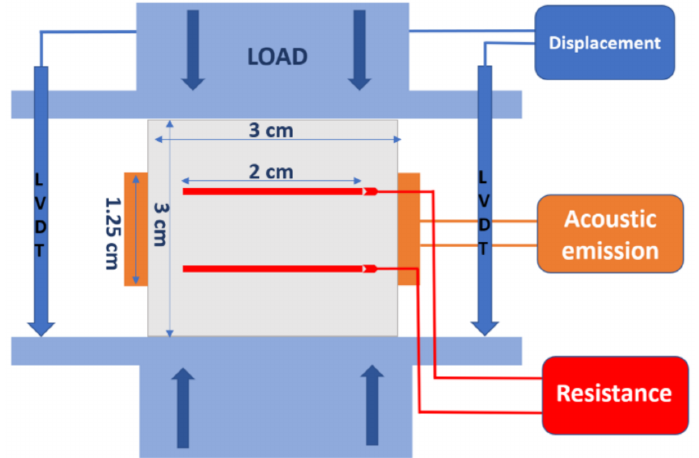
Figure 2. Schematic representation of experimental setup (not to scale) with indicated sizes of sample, electrical connectors and acoustic